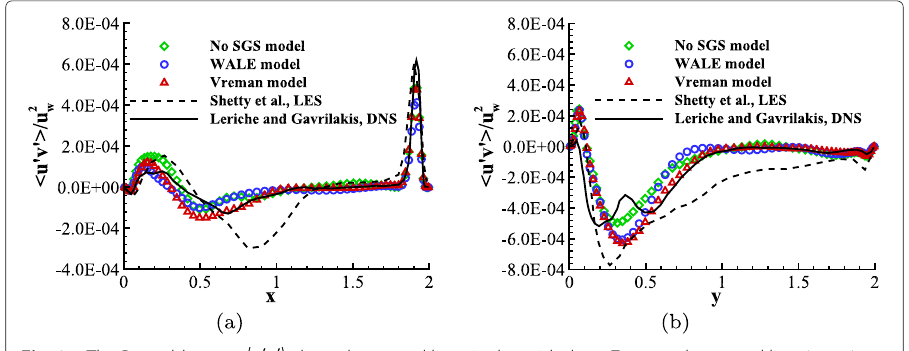
Fig. 21 The Reynolds stress b the central line ( 1, y ,1